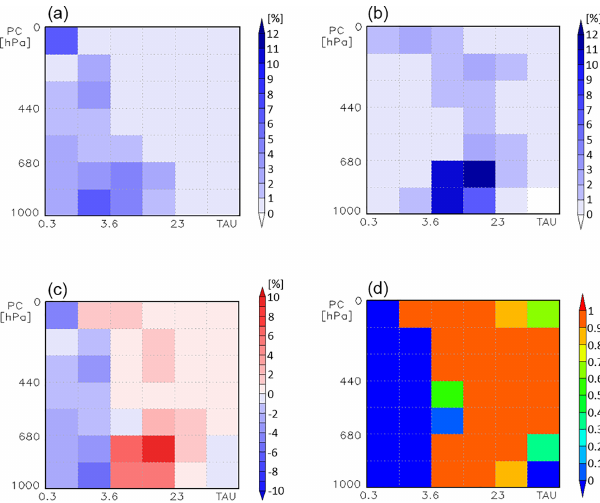
Figure 5. ISCCP cloud amount of the July mean for the Hawaiian Trade Cumulus Region (15–35 ◦ N, 160 ◦ E–140 ◦ W), indicated by the black square in Figure 4b, for different categories of the cloud top pressure (PC) and cloud optical thickness (TAU). Each panel is for (a) ISCCP observation, (b) MIROC5 PPE ensemble mean, (c) model bias, namely (b) minus (a) , and (d) fraction of the PPE ensemble members with positive bias.